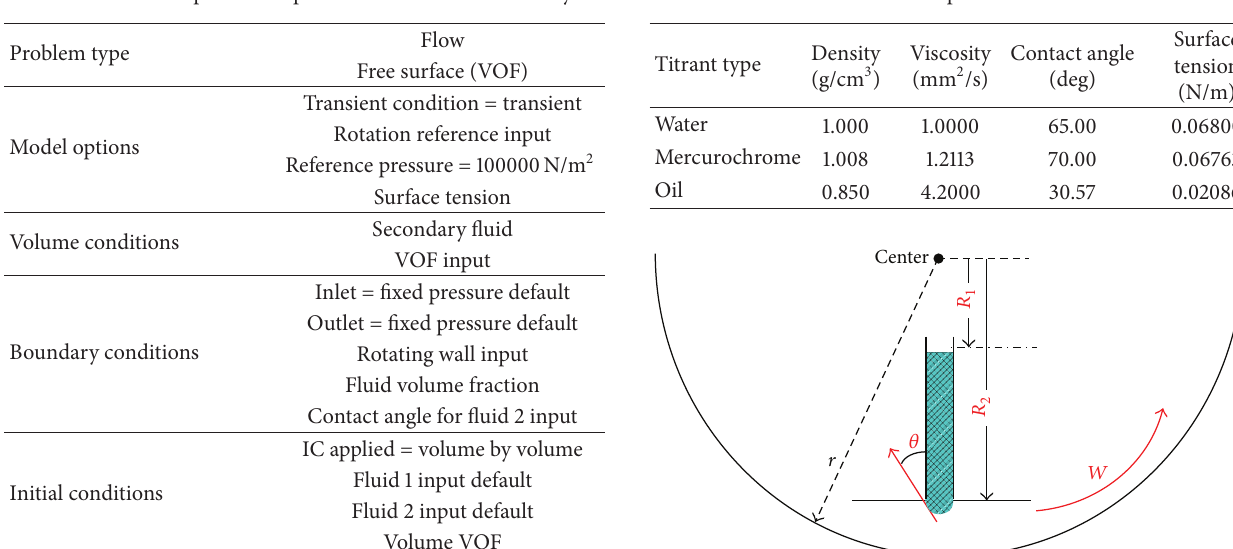
Table 1: Basic assumptions and parameters for numerical analyses. Table 2: The comparison of titrants.